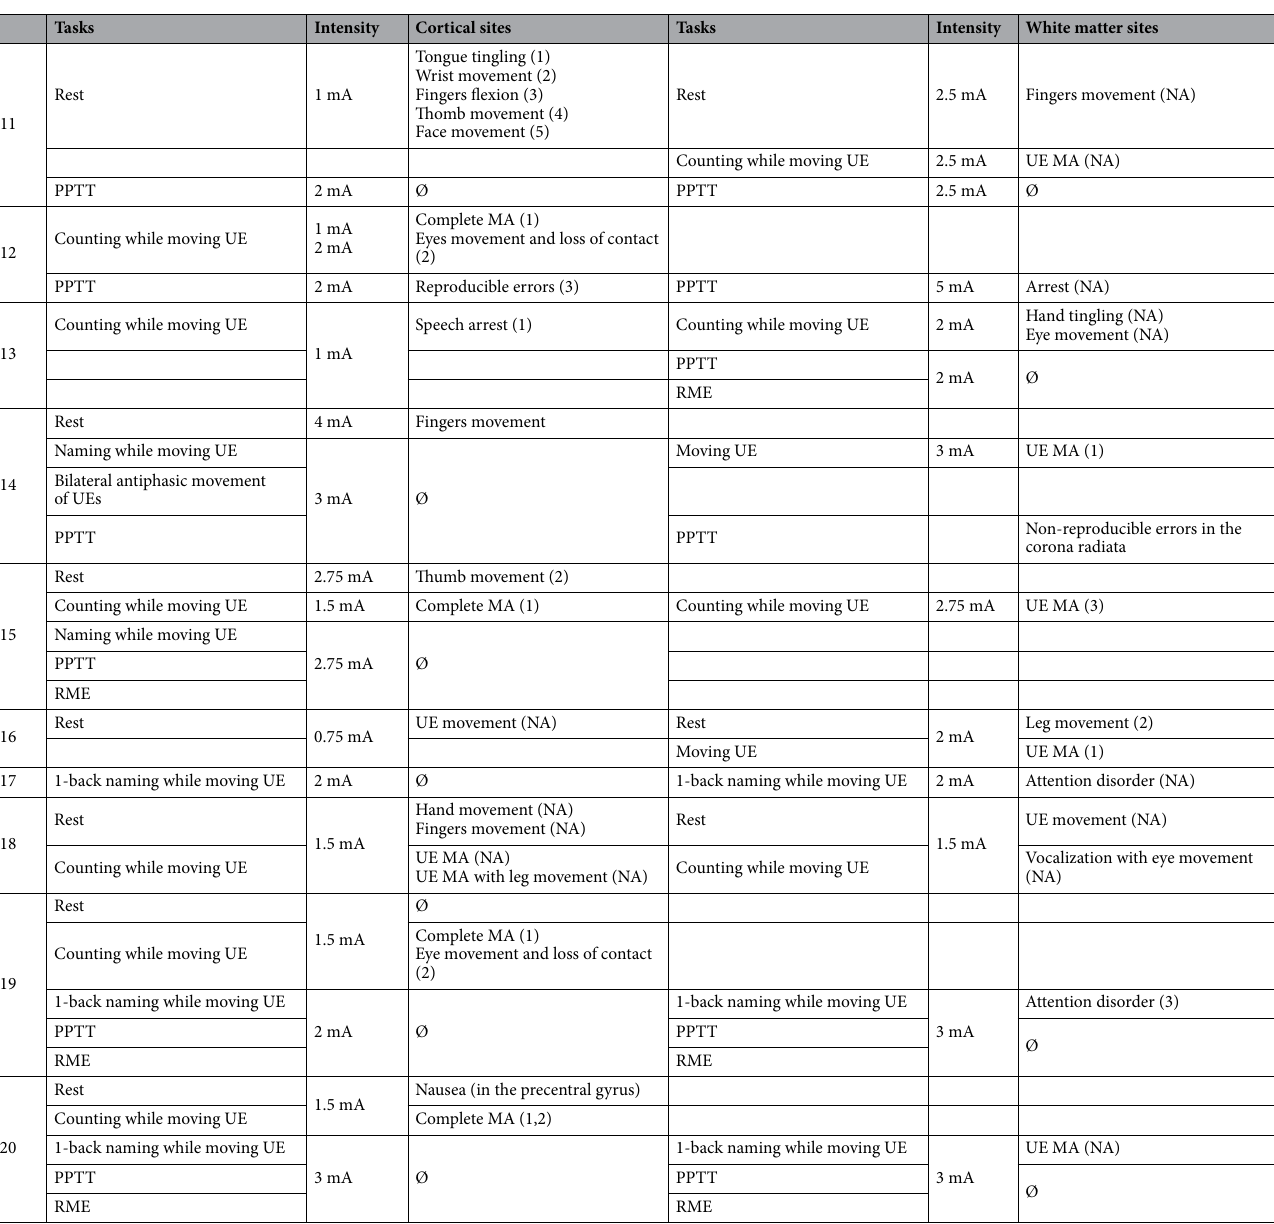
Table 2. Functional sites intraoperatively identified. The numbers in brackets refer to the tag number on respective photographies of Fig. 2. MA = motor arrest ; LE = lower extremity ; UE = upper